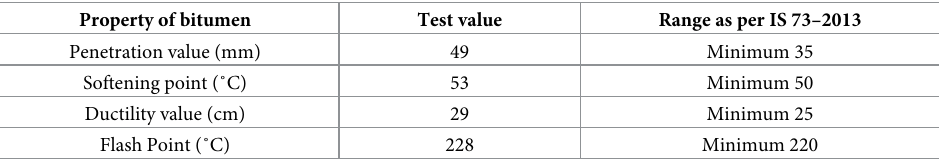
Table 1. Physical properties of bitumen grade